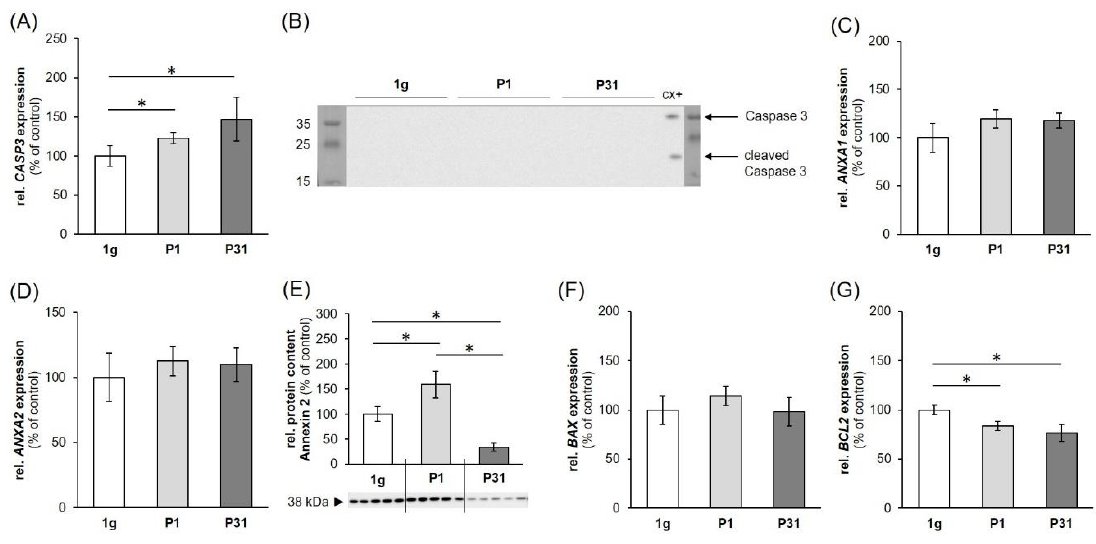
Figure 4. Influence of short-term microgravity on the gene expression: ( A ) CASP3 , ( C ) ANXA1 , ( D ) ANXA2 , ( F ) BAX , ( G ) BCL2 ; and protein content ( B ) caspase 3, ( E ) annexin 2 regulators of apoptosis. The data are given as mean ± standard deviation. * p < 0.05 vs. 1 g -control. CX+ colon cancer cells served as positive control for programmed cell death.